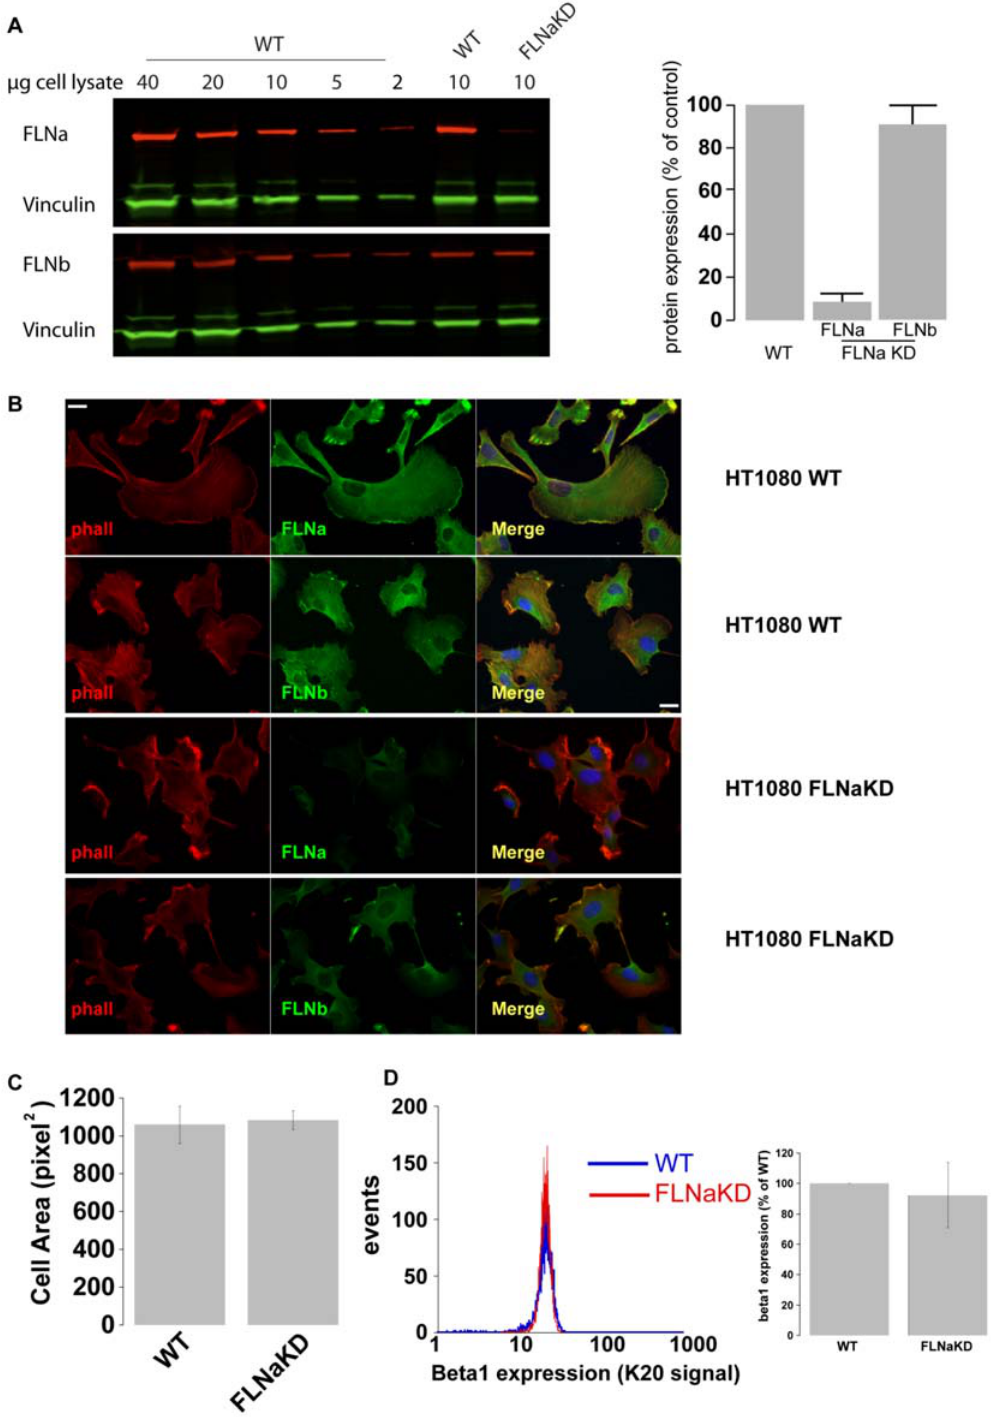
Figure 1. Generation of FLNaKD cells. A ) FLNa and FLNb expression in FLNaKD cells was quantified comparing 10 m g of cell lysate to a curve of cell lysates prepared from HT1080 WT cells. Vinculin expression was used as loading control. The bar chart depicts average of 4 independent western blots normalized to control 6 SEM. B ) HT1080 WT or FLNaKD were plated on 5 m g/ml FN coated coverslips overnight, fixed, permeabilized and stained with anti-FLNa (FLNa), anti-FLNb (FLNb), phalloidin (phall) and DAPI (shown in blue in the merged image). Bar=20 m m. C ) HT1080 WT and HT1080 FLNaKD cells were detached, mixed and seeded on a 3.5 cm petri dish coated with 5 m g/ml FN, allowed to adhere and spread. Cells were fixed after 1 hour and stained with anti-FLNa to discriminate between WT and FLNaKD cells. The area was measured by manually rendering the cell contour in the phase images. 1 pixel 2 =1.664 m m 2 (Sample size WT=74; FLNaKD=82 from 5 independent experiments). Error bars show SEM. D ) Integrin beta1 present on the membrane surface of WT and FLNaKD cells. The left panel show histogram a representative histogram plot, the right panel shows the average of 4 experiments 6 standard deviation.